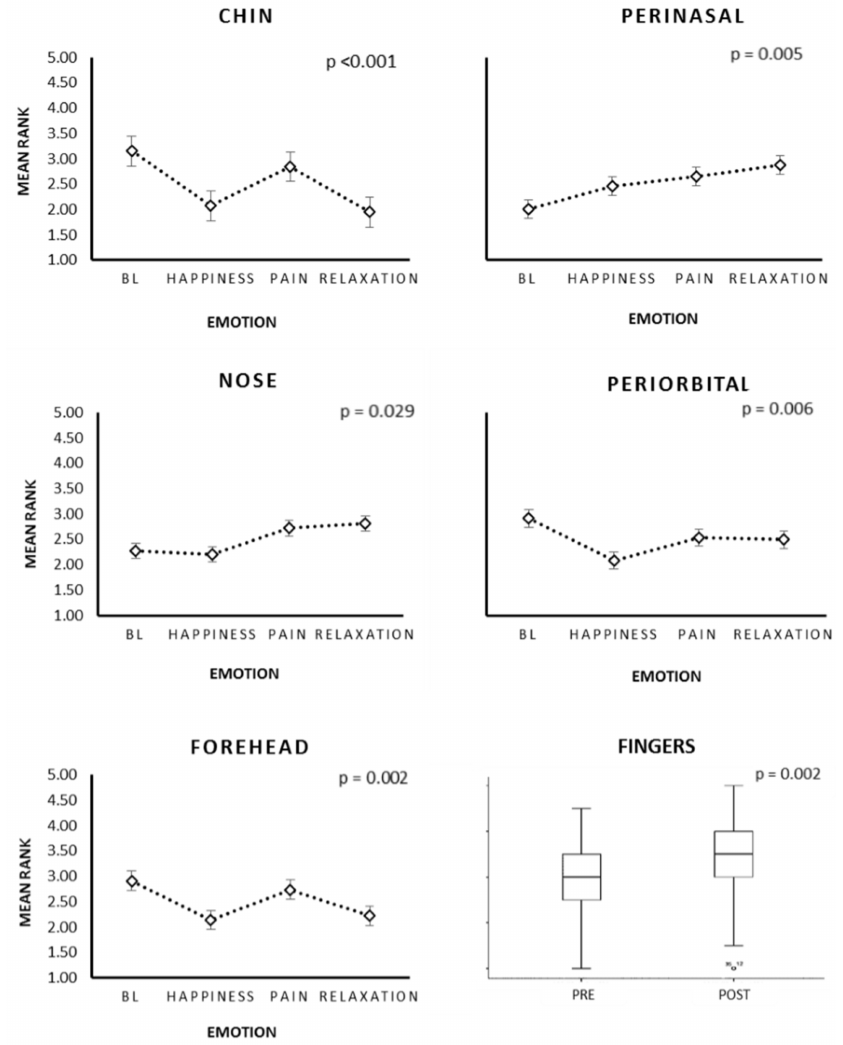
Figure 3. Changes in temperature of each facial region and fingers. The voluntary emotional facial expressions and relaxation had a statistically significant effect. BL =